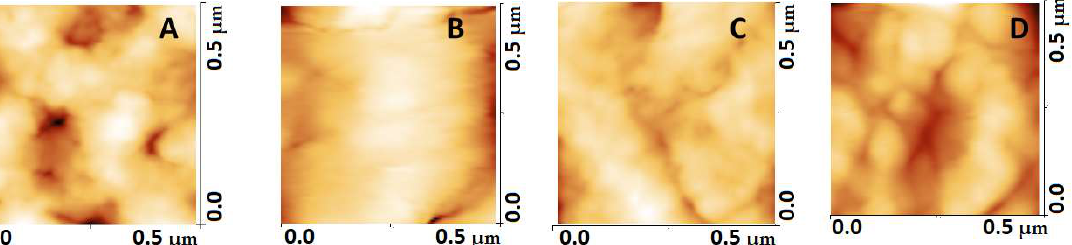
Figure 2. Comparison of the ultrastructure of the platelet membrane in healthy individuals ( A ), patients with PD ( B ), ALS ( C ) and AD ( D ). The images were taken in the middle part (0.5 × 0.5 µm) of the platelets.